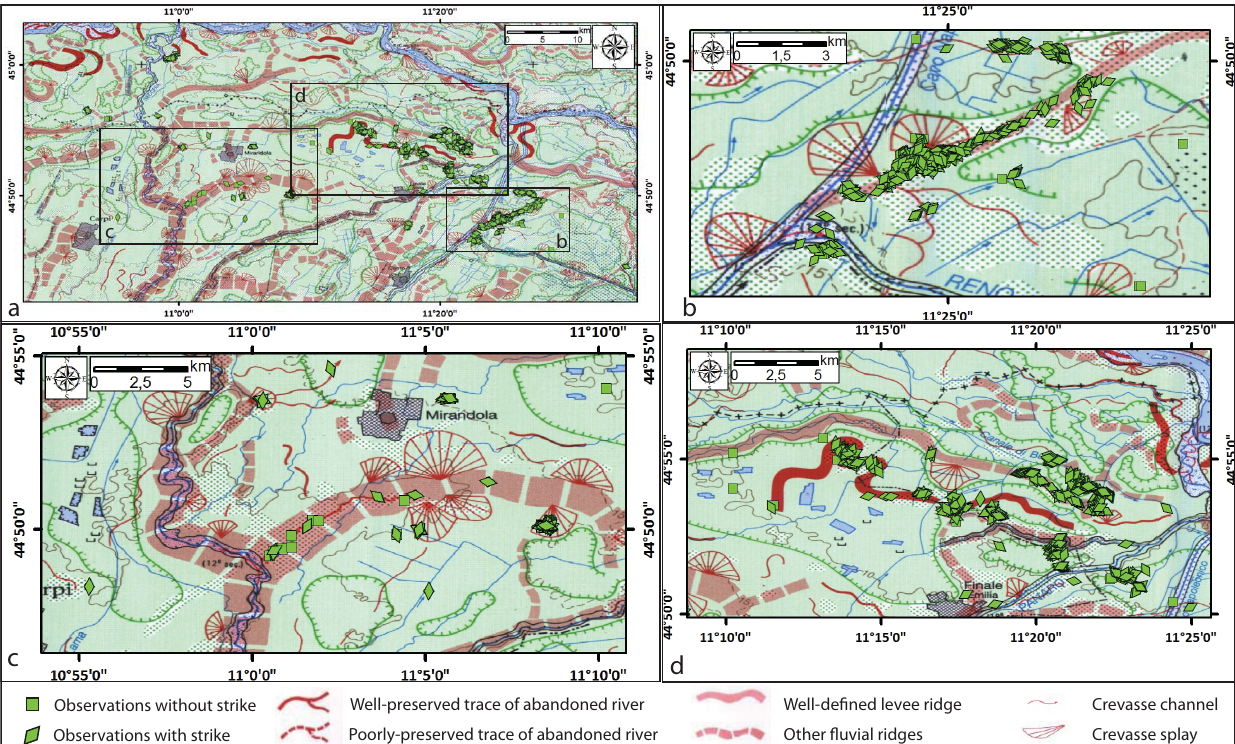
Fig. 7. (a) Comparison between the geomorphic characteristics of the area (Castiglioni et al., 1999) and the location of the observed geological effects. (b) , (c) and (d) Details of the SE, SW and NE areas, respectively.